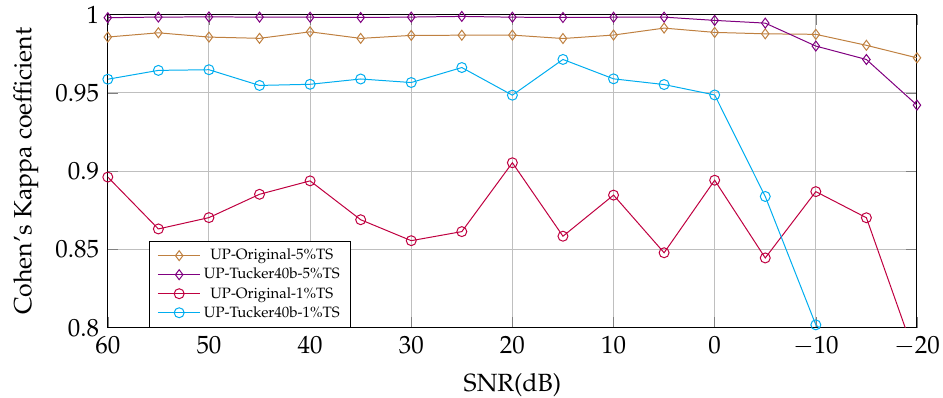
Figure 15. University of Pavia. Cohen’s Kappa coefficient obtained using 3DCNN DL model trained for 40 epochs from the original UP HSI and compressed with TKD to 40 tensorial bands. From 60 to − 5 dB, Tucker improved the performance for Cohen’s Kappa